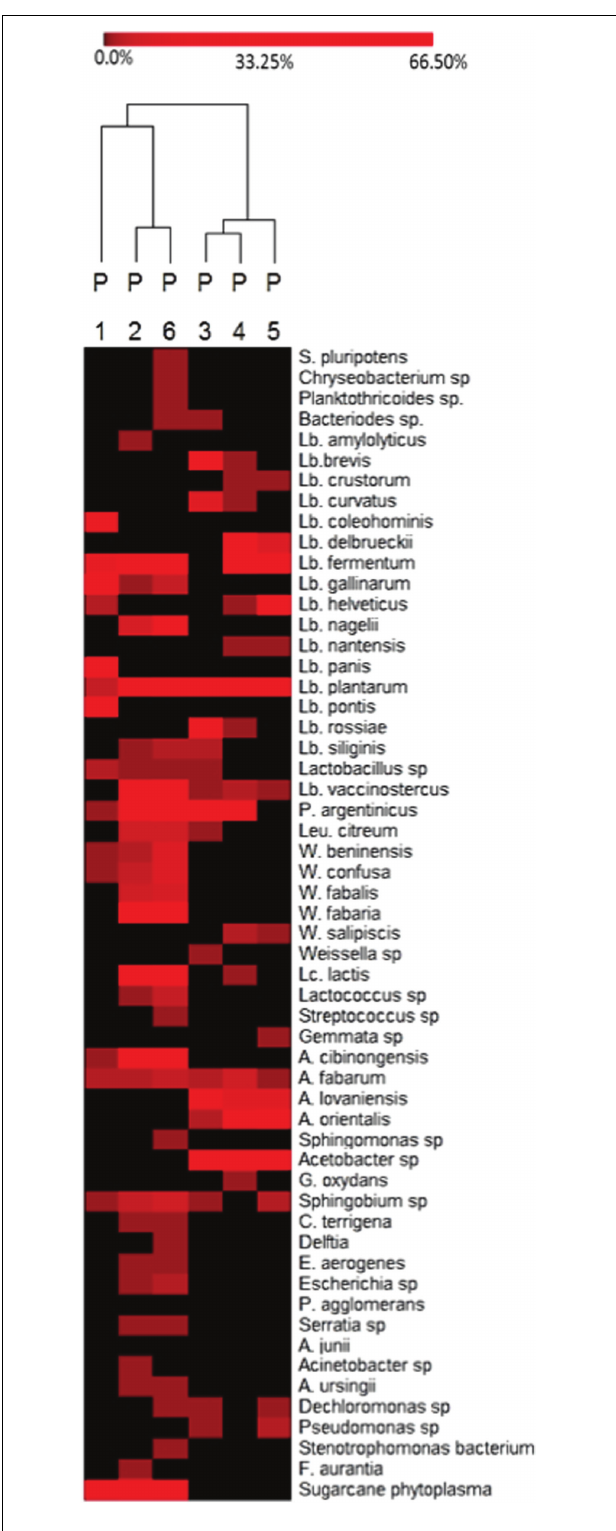
FIGURE 3 | Heat-map depicting bacterial diversity and relative abundance of species in six Masa agria samples from different producers (P, producers), as revealed by 16S rRNA pyrosequencing. The color key defines the percentages of OTUs in the